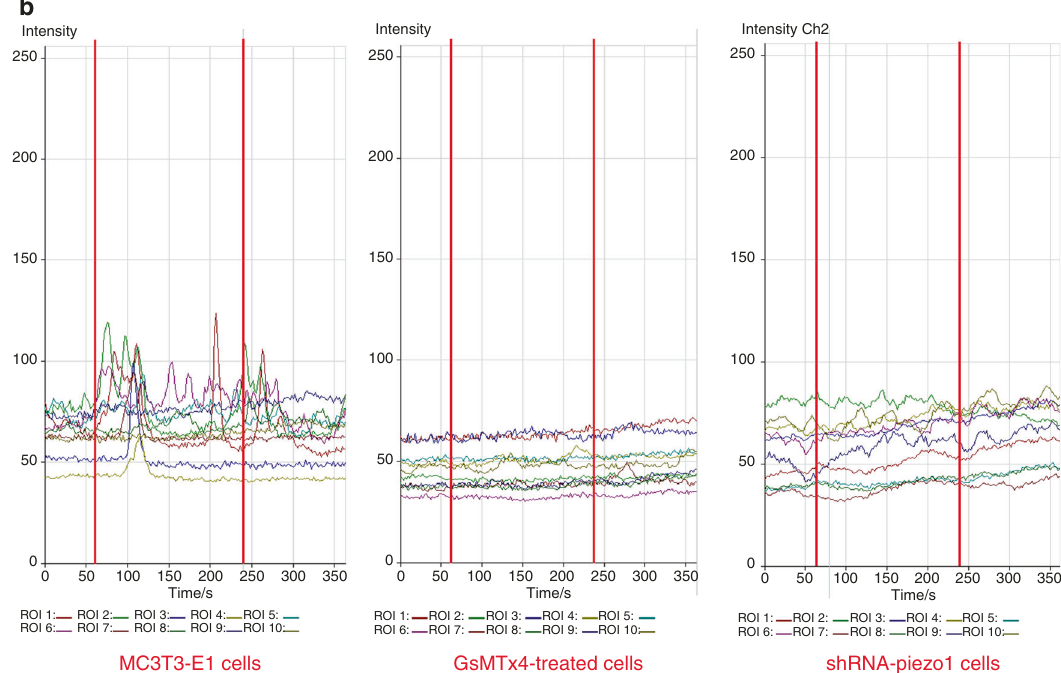
Fig. 3 Fluorescence imaging of calcium oscillation and the effects of LIPUS stimulation on different groups of cells. a After LIPUS stimulation, the Fluo-8-labeled cells exhibited increased intracellular calcium levels at different time points. The red arrows show the two-cell calcium oscillation phenomenon. Scale bars, 50 μ m. b Representative intracellular calcium traces of three groups of cells (MC3T3-E1, shRNA-Piezo1, and GsMTx4-treated cells) are shown as the fold increase in Fluo-8 intensity in response to LIPUS stimulation. The experiment was performed for six total minutes, including 1 min of baseline without LIPUS stimulation, 3 min of active stimulation (between the two red lines), and 2 min of regression. Time-lapse sequences were collected every 1.8 s for 6 min. In each fi eld of interest, the fl uorescence intensities of 10 cells were quanti fi ed using LSM Image Browser